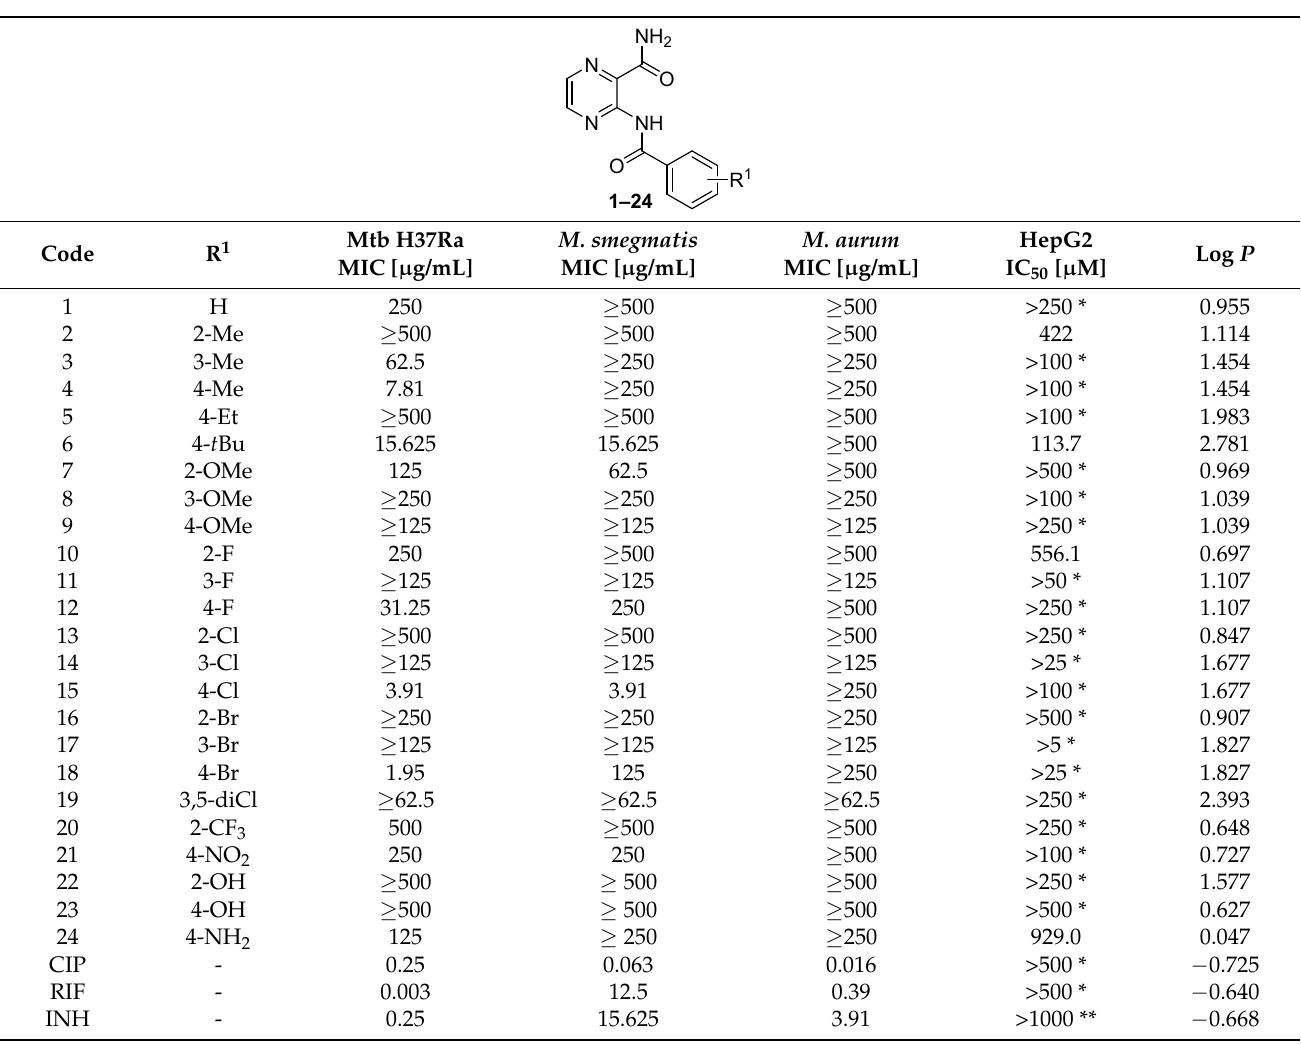
Table 1. Antimycobacterial activity and HepG2 cytotoxicity of compounds 1 – 24 .